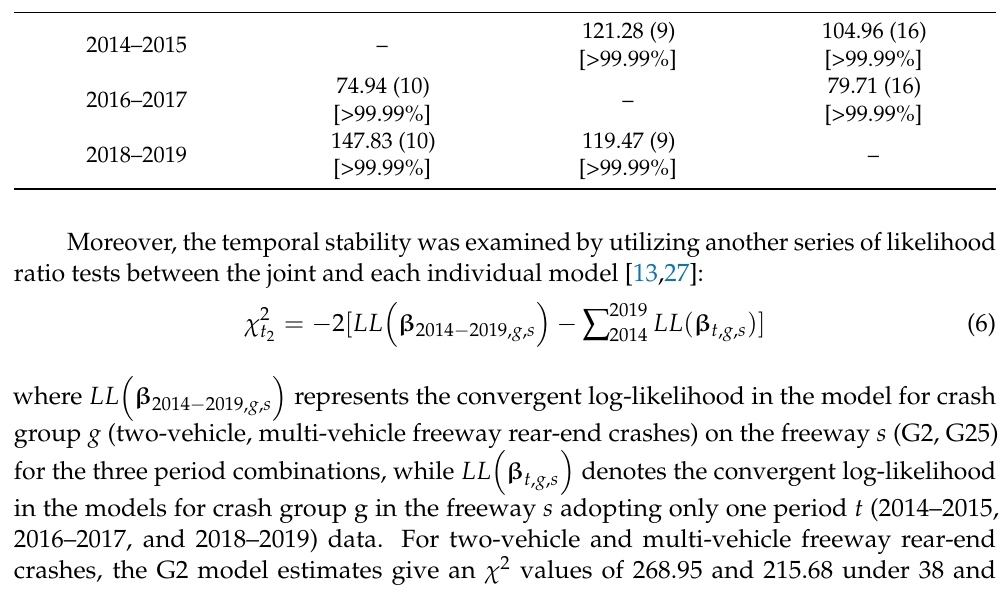
Table 7. Results of LRT between different year periods (multi-vehicle G25 rear-end crash models). y 1